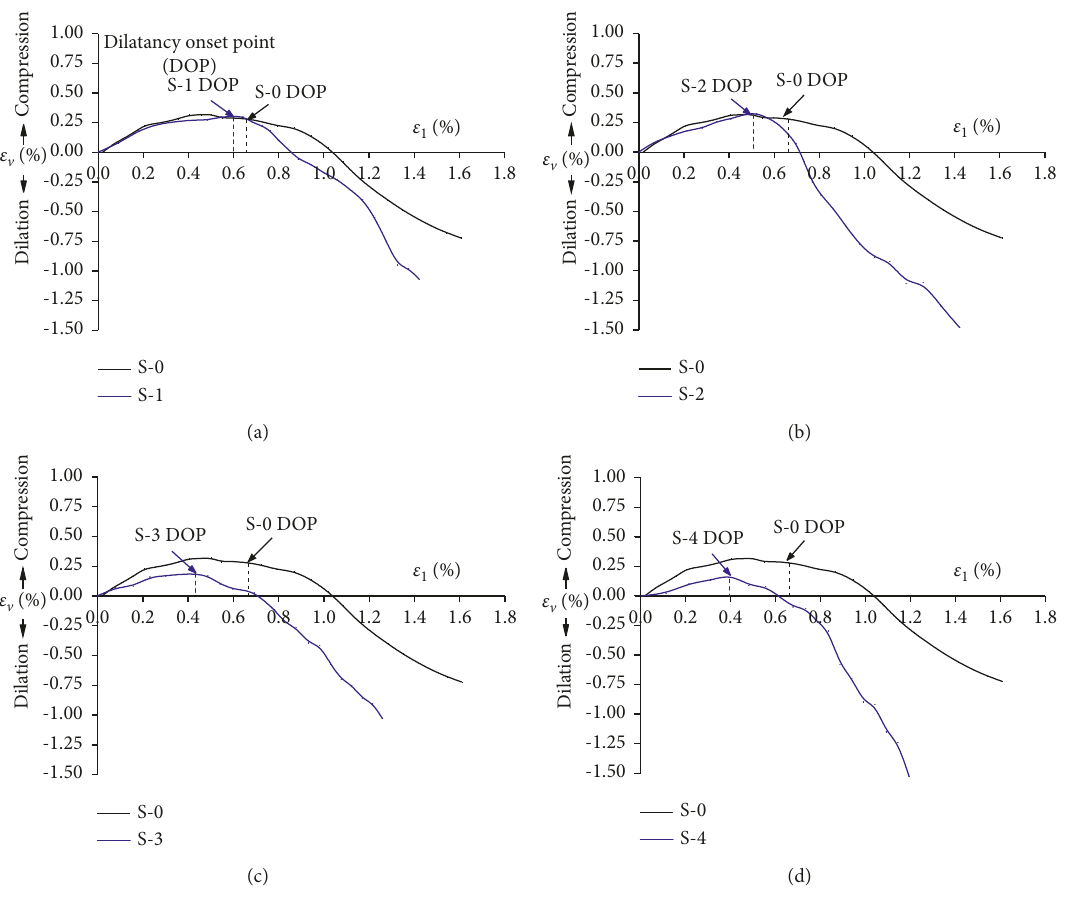
Figure 9: Volumetric strain variation curve of PD rock. (a) S-1 rock sample. (b) S-2 rock sample. (c) S-3 rock sample. (d) S-4 rock